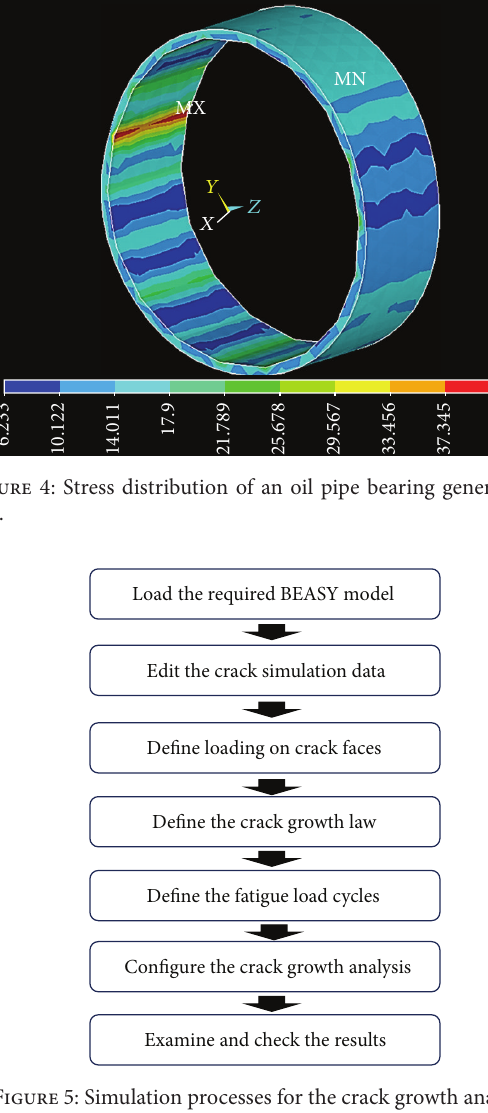
Figure 7: Crack setting location of an oil pipe with general metal loss corrosion and the crack appearing on the maximal